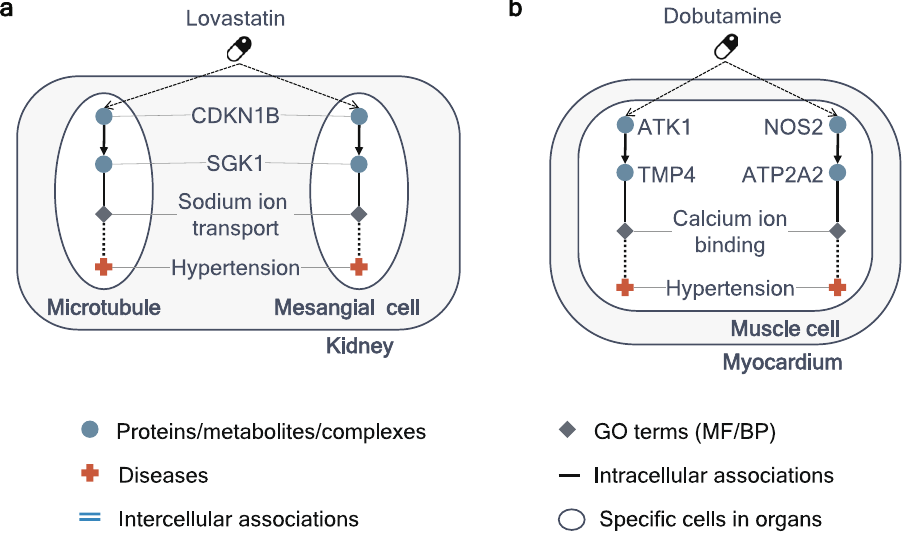
Figure 6. Uses of GO terms in the CODA network to infer known drug-disease associations. ( a ) The path from lovastatin to hypertension in CODA. Lovastatin is associated with hypertension through a biological process, sodium ion transport, in kidney. ( b ) The path from dobutamine to hypertension in CODA. Dobutamine is associated with hypertension through a molecular function, calcium ion binding, in